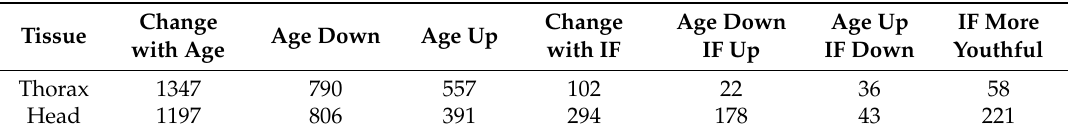
Table 1. Genes with Fold Changes due to Aging and Intermittent